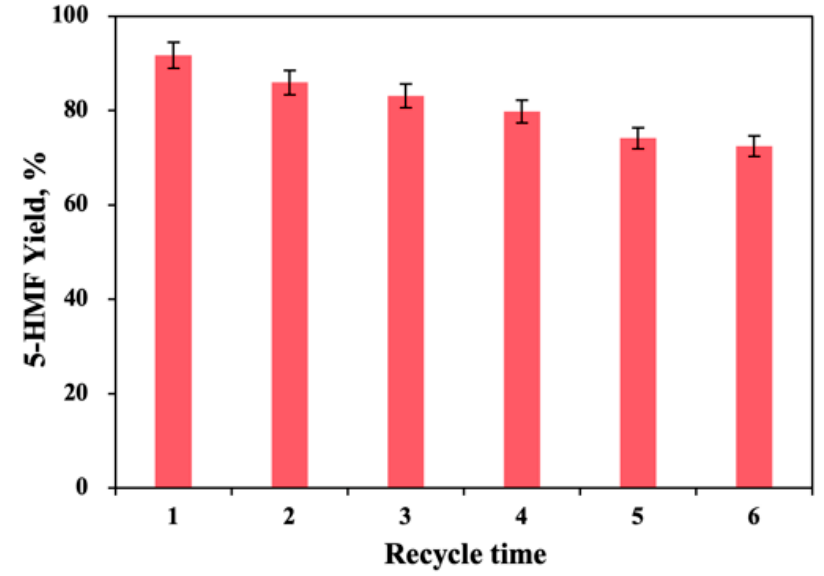
Figure 5. The reuse of the catalytic system on the 5-HMF generation.